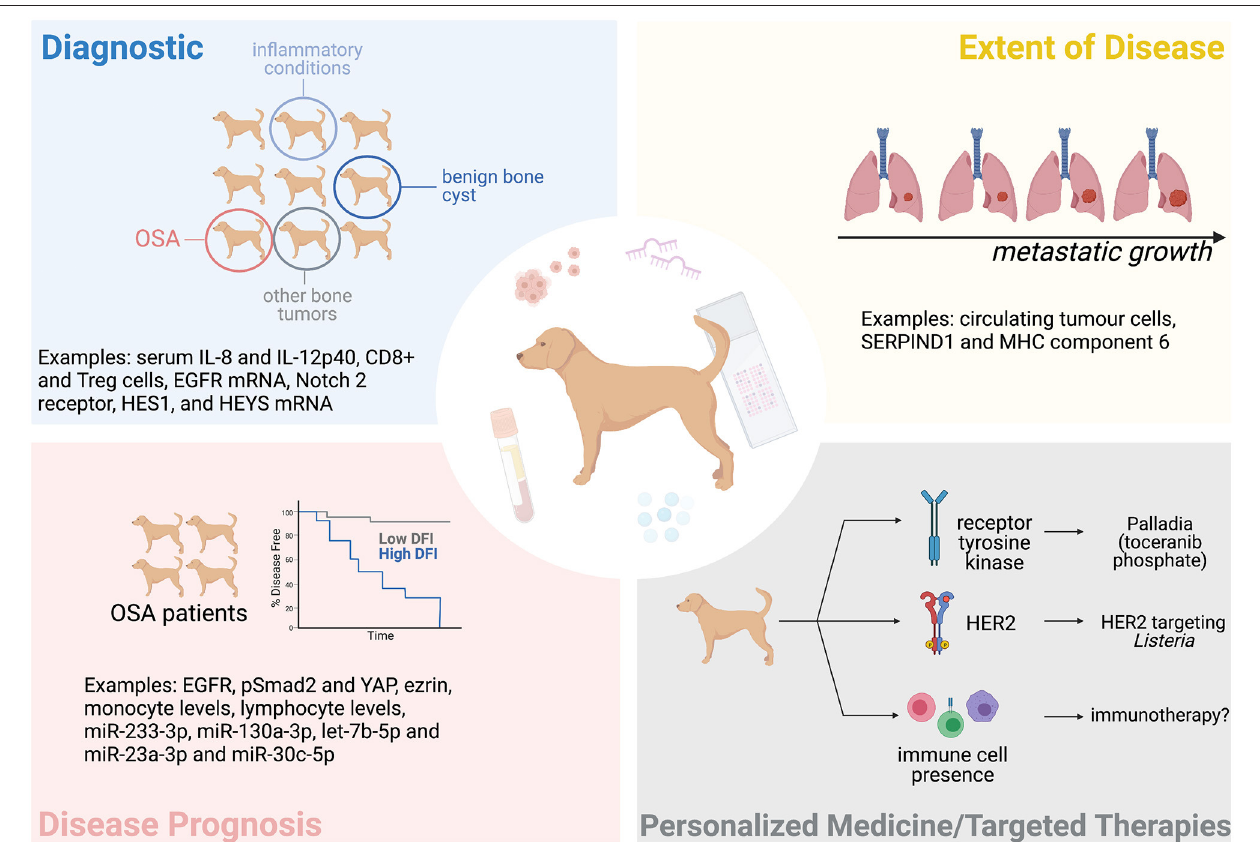
FIGURE 1 | The potential of biomarkers in the clinical management of canine OSA. Tissue and blood-based (liquid) biopsies could help diagnose OSA, determine the extent of a patient’s disease (metastatic progression), the patient’s prognosis, and help personalize treatment. Some examples mentioned in this manuscript are indicated here. Figure created with